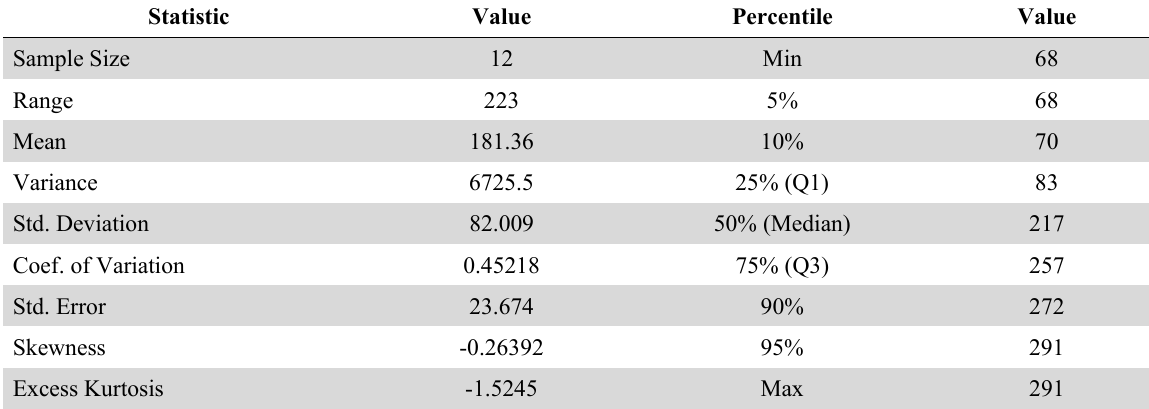
Results of statistical analysis of rainfall data